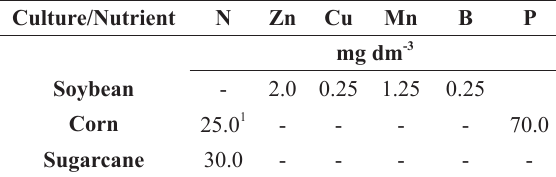
Amount of nutrients supplied to each pot in the assays with corn, soybean and sugarcane.